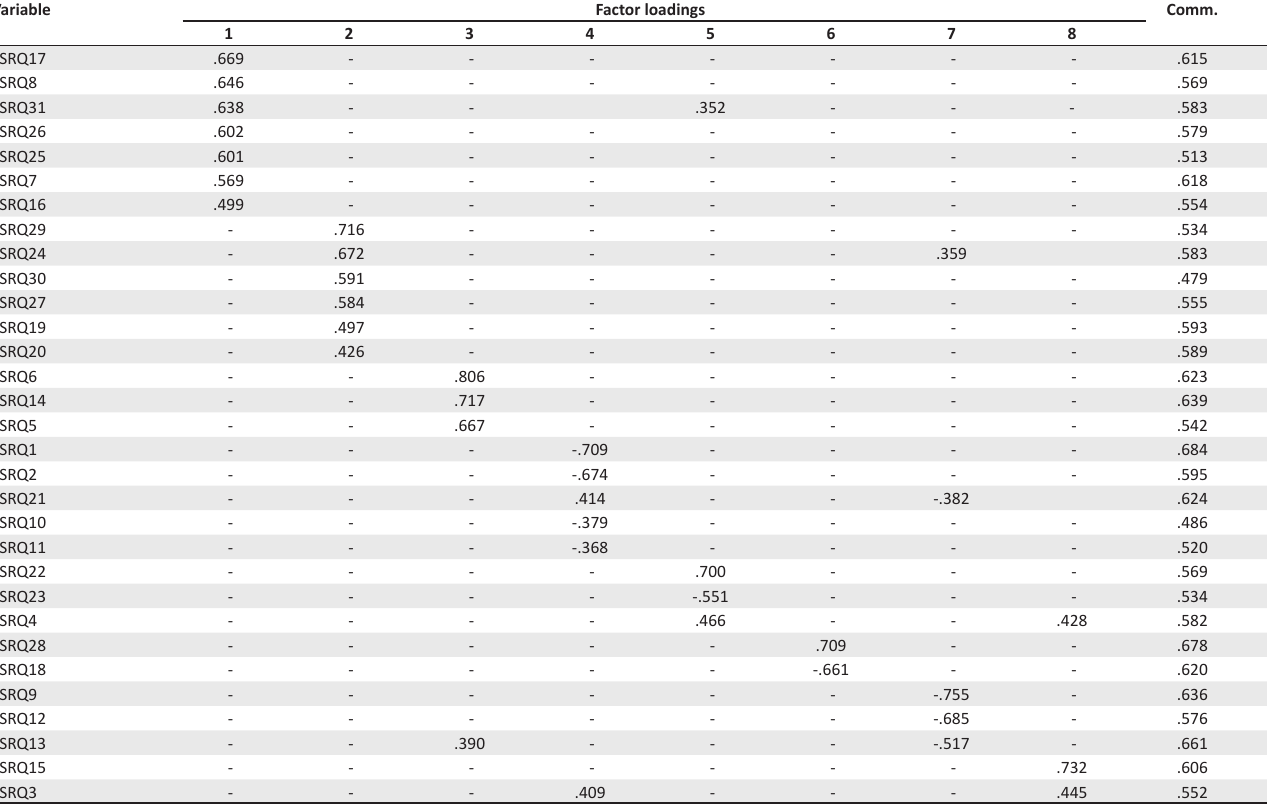
TABLE 2: Pattern matrix of exploratory factor analysis using the principal components method of factor extraction, with oblimin rotation. Variable Factor loadings Comm.